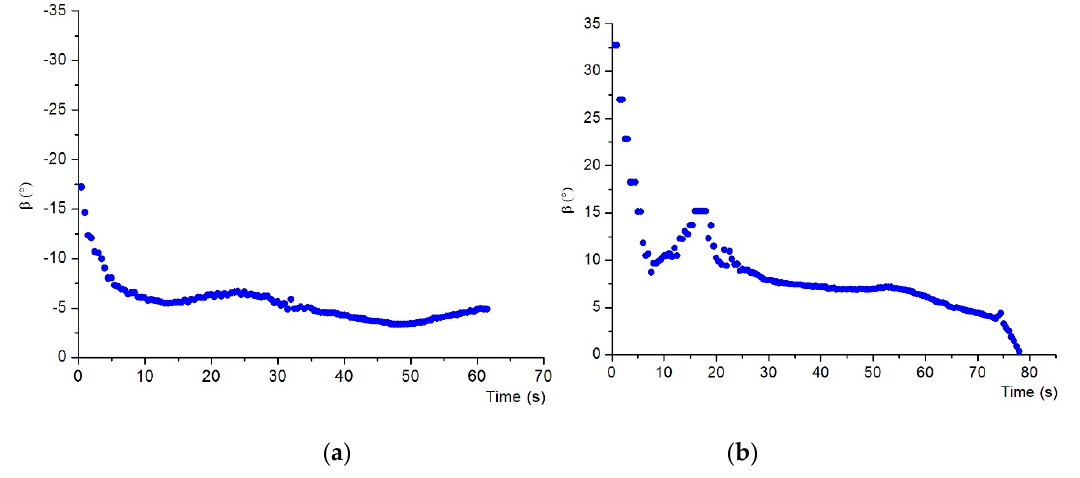
Figure 22. Deflection angle measured by the magnetic sensor during docking in extreme position. ( a ) Docking from left-hand side of the dock entrance. ( b ) Docking from right-hand side of the dock entrance.